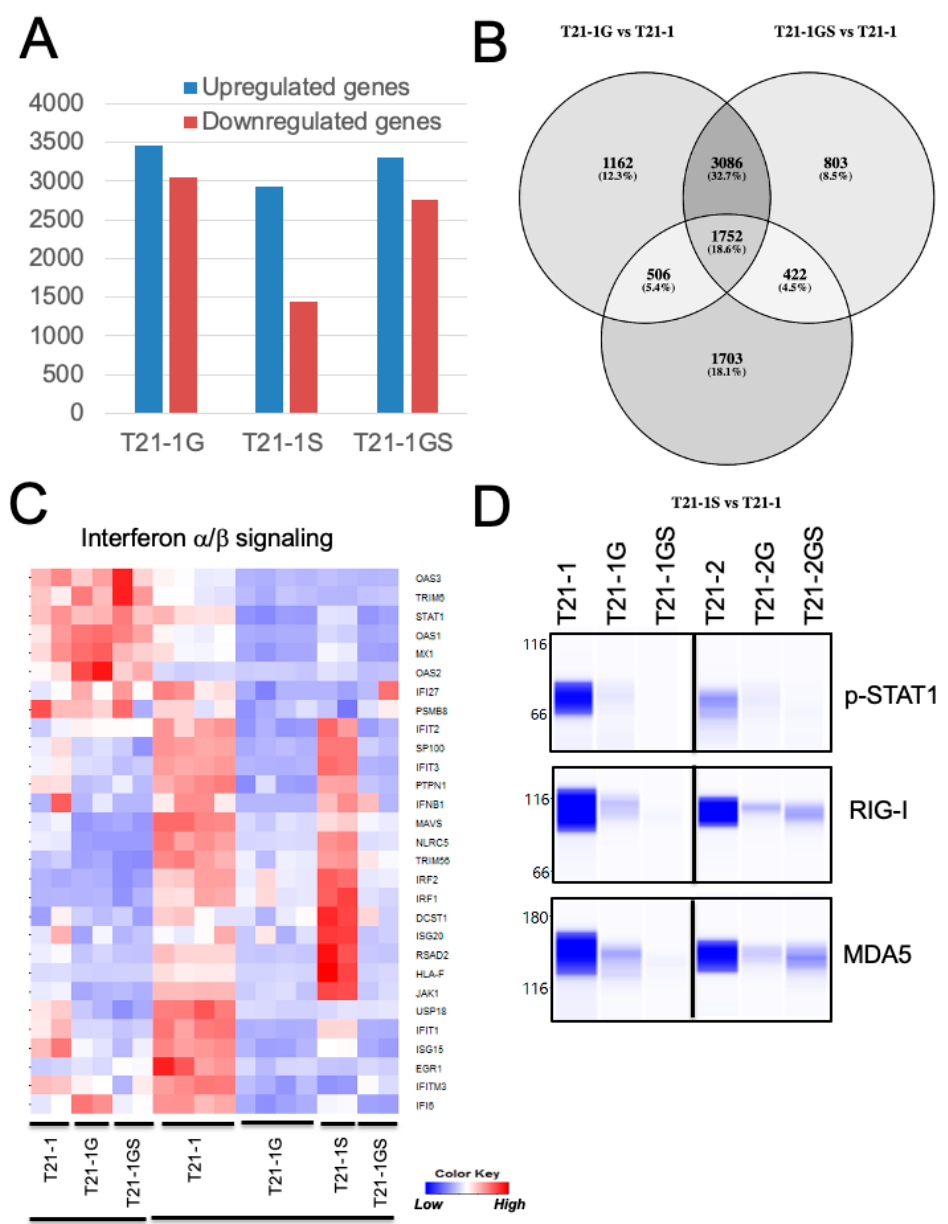
Figure 5. ( A ) Graph showing the number of differentially regulated genes (FDR < 0.05, log fold change >2 or < − 2) in the indicated megakaryocytes with respect to wildtype T21-1. ( B ) Venn diagram of the differentially regulated genes. The shading is proportional to the percentage of shared genes. ( C ) Heat map showing the expression of genes belonging to the interferon α / β signaling pathway. ( D ) Wes immunoblot analysis of key proteins belonging to the interferon α / β signaling pathway in megakaryocytes. Total protein was quantitated using total protein analysis kit and used for normalization.